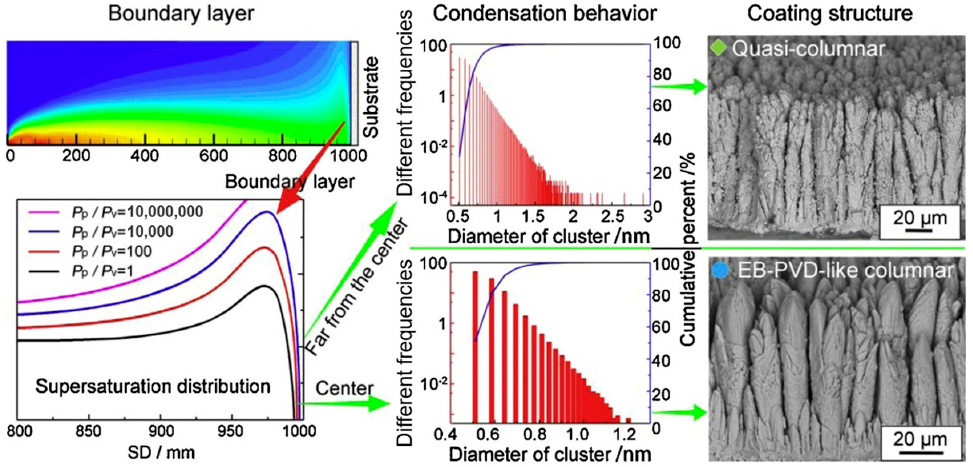
Figure 30. Effect of condensation behavior on the coating structure [164,165]